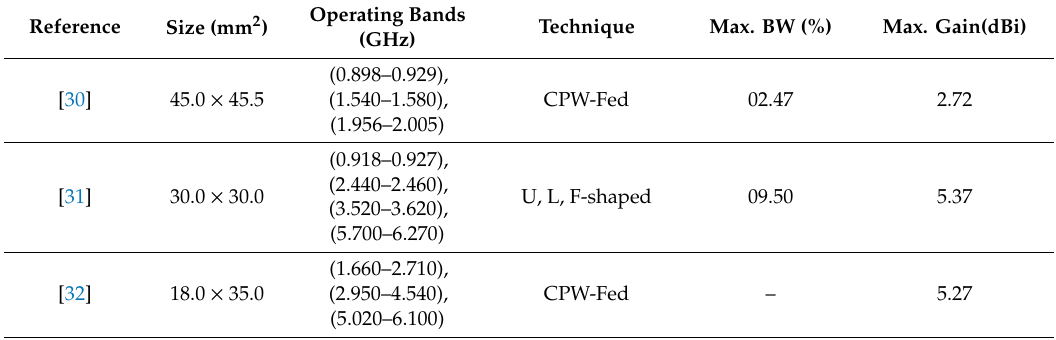
Table 1. Comparison of a designed antenna with others in the state of the